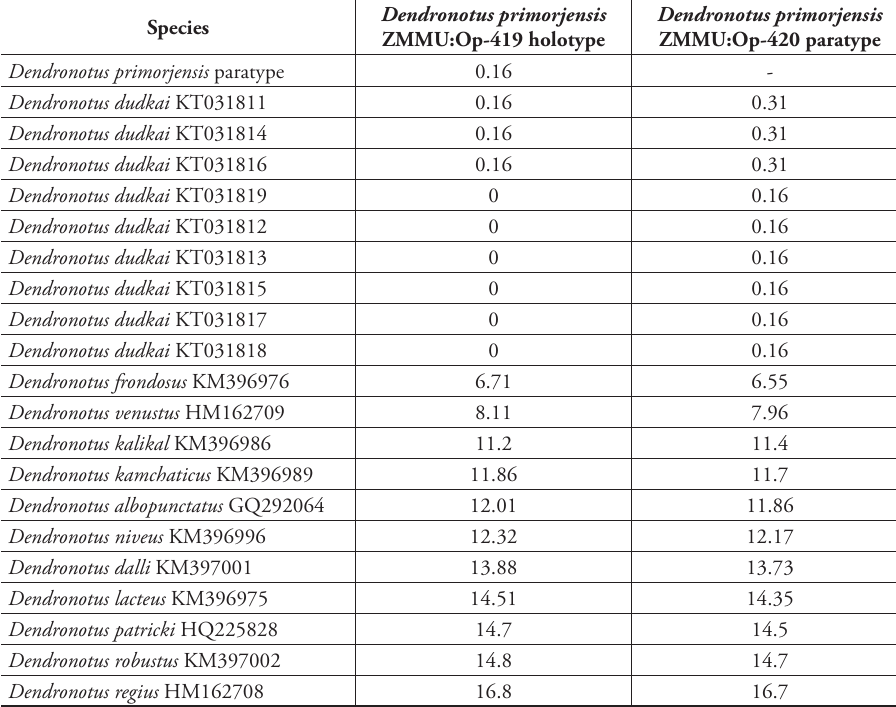
Table 2. Uncorrected COI p-distances (%) between holotype and paratype of Dendronotus primorjensis and other species of the genus Dendronotus